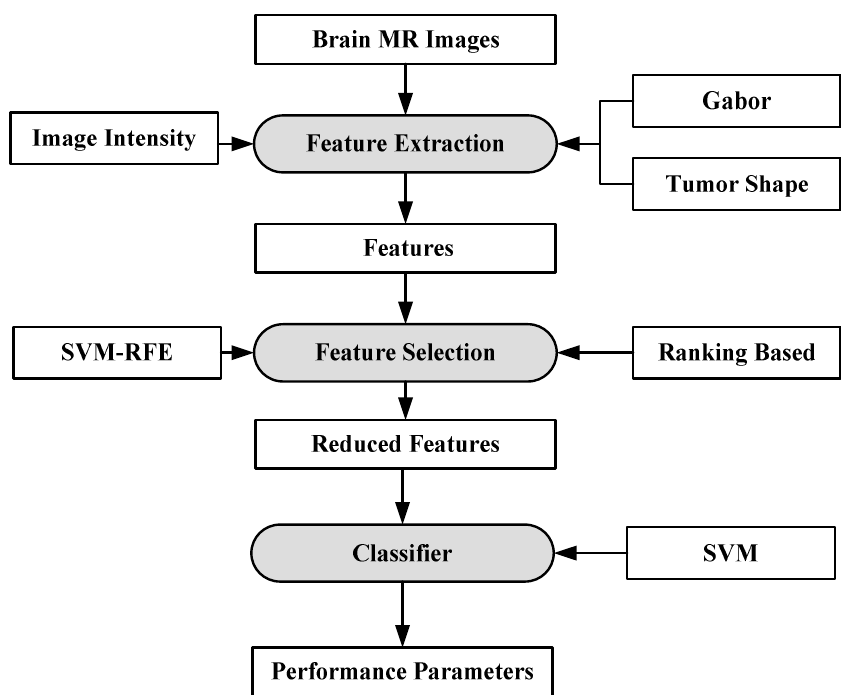
Figure 8. Process model using SVM-based grade estimation method [92].